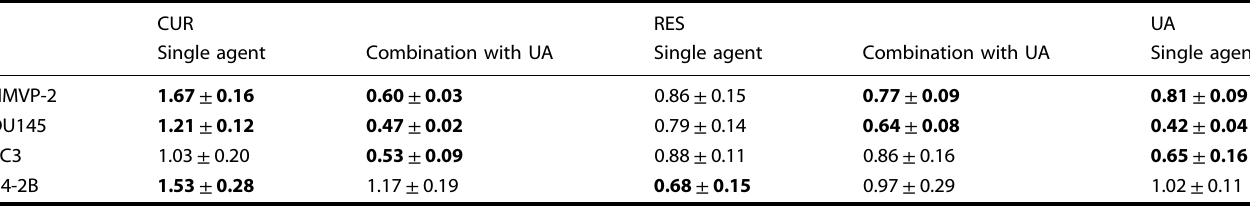
Table 2. Induction of ROS in treated murine and human PCa cells